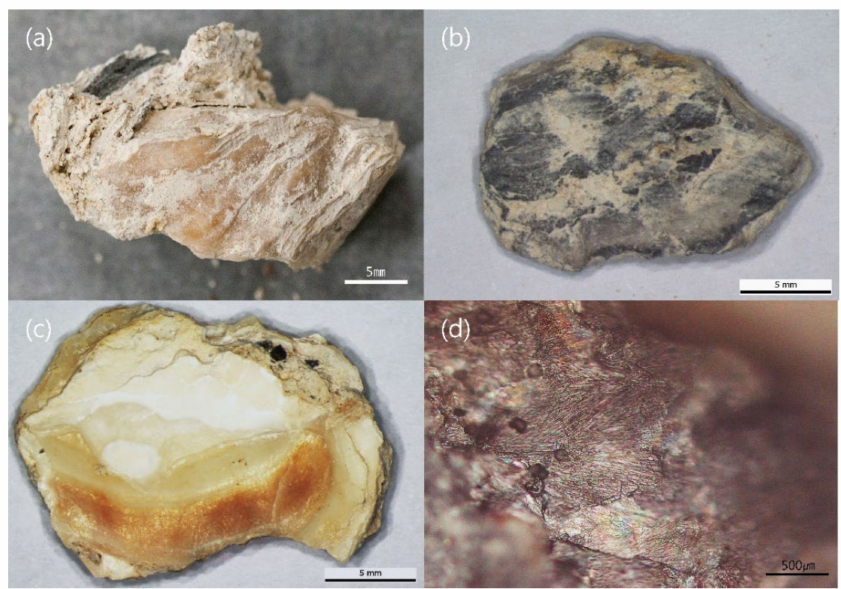
Figure 9. Sample details of shell fragment in plaster: ( a , b ) Surface of shell fragment. ( c ) Ventral of the shell. ( d ) Optical images of glossy area by chitinous substance in nacreous layer (or folia layer).